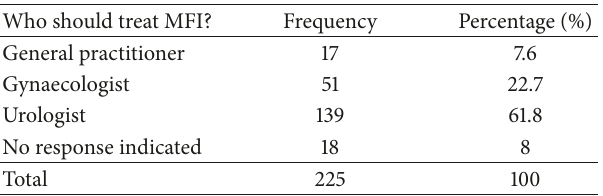
Table 4: Respondents’ indicated response to “who should treat male factor infertility (MFI)?” Who should treat MFI? Frequency Percentage (%) General practitioner 17 7.6 Gynaecologist 51 22.7 Urologist 139 61.8 No response indicated 18 8 Total 225